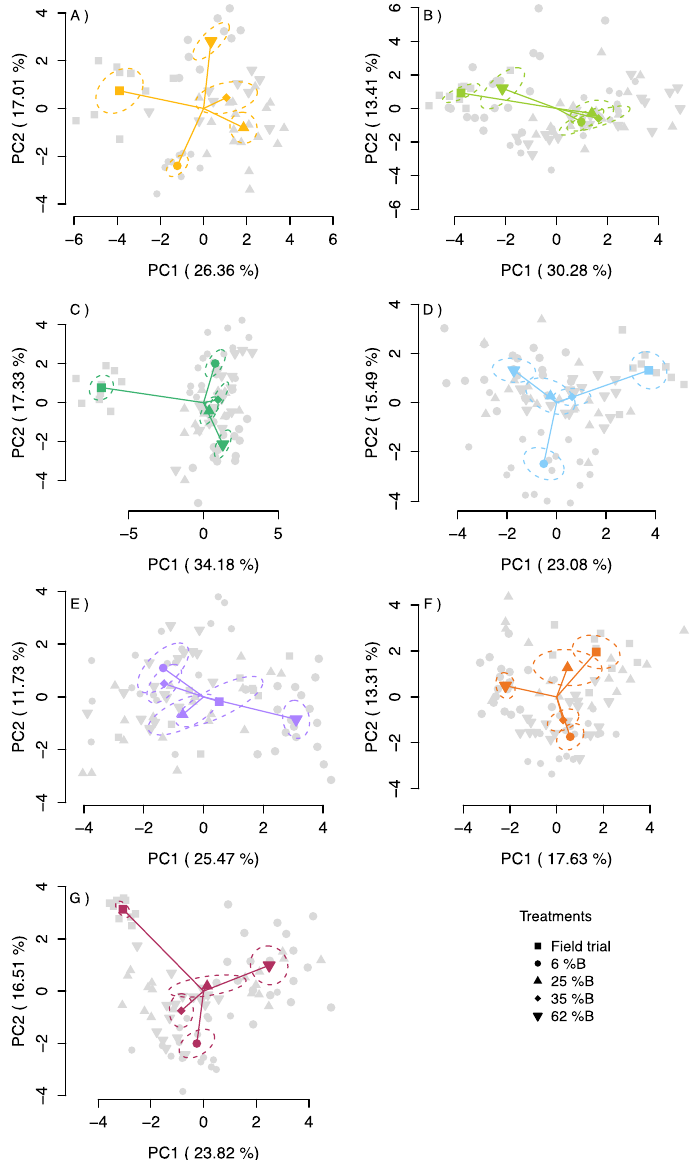
Figure 6. Principal component analysis (PCA) of the measured traits of each species: ( A ) Alnus , ( B ) Ulmus , ( C ) Ocimum , ( D ) Lactuca , ( E ) Melissa , ( F ) Raphanus and ( G ) Triticum , grown under 6% B, 25% B, 35% B and 62% B light. Each lighter point ( n = 18) corresponds to a plant and solid ones to the average weighted centroids of each light treatment, where the name of each species is mentioned in the respective upper right corner. Ellipses correspond to the standard error of the weighted centroids with a confidence interval of